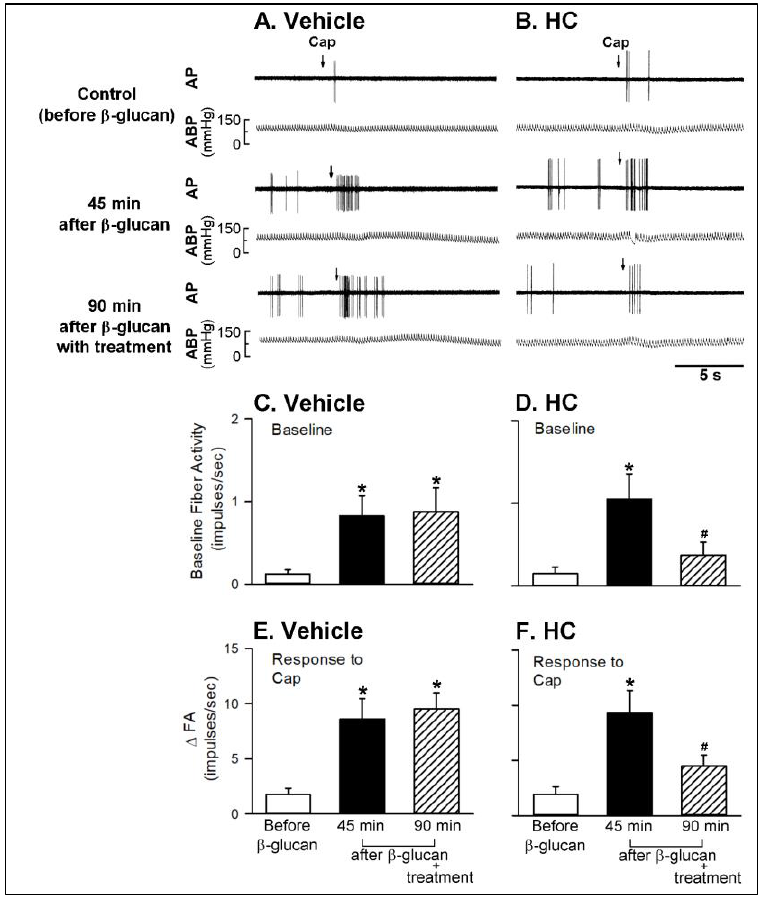
Figure 7. Experimental records illustrating the effects of treatment of vehicle or HC-030031 (HC, 8 mg/kg) on the β-glucan-induced potentiating on the responses of capsaicin-sensitive lung vagal (CSLV) afferents to capsaicin (Cap, 0.75 μg/kg; arrows) after intratracheal instillation of β-glucan (5 mg/0.1 mL/rat) in anesthetized, artificially ventilated rats. ( A ) and ( B ): treatment with vehicle or HC in two anesthetized, artificially ventilated rats (vehicle: 300 g; β-glucan: 290 g), respectively. AP, action potential; ABP, arterial blood pressure. ( C ) and ( D ): the effects of vehicle and HC on the β-glucan- induced elevation of the baseline fiber activity of CSLV afferents, respectively. ( E ) and ( F ): the effect of vehicle and HC on the β-glucan-induced potentiating on the responses of CSLV afferents to the capsaicin injection, respectively. FA, fiber activity. Data are means ± SE ( n = 8). See the legend of